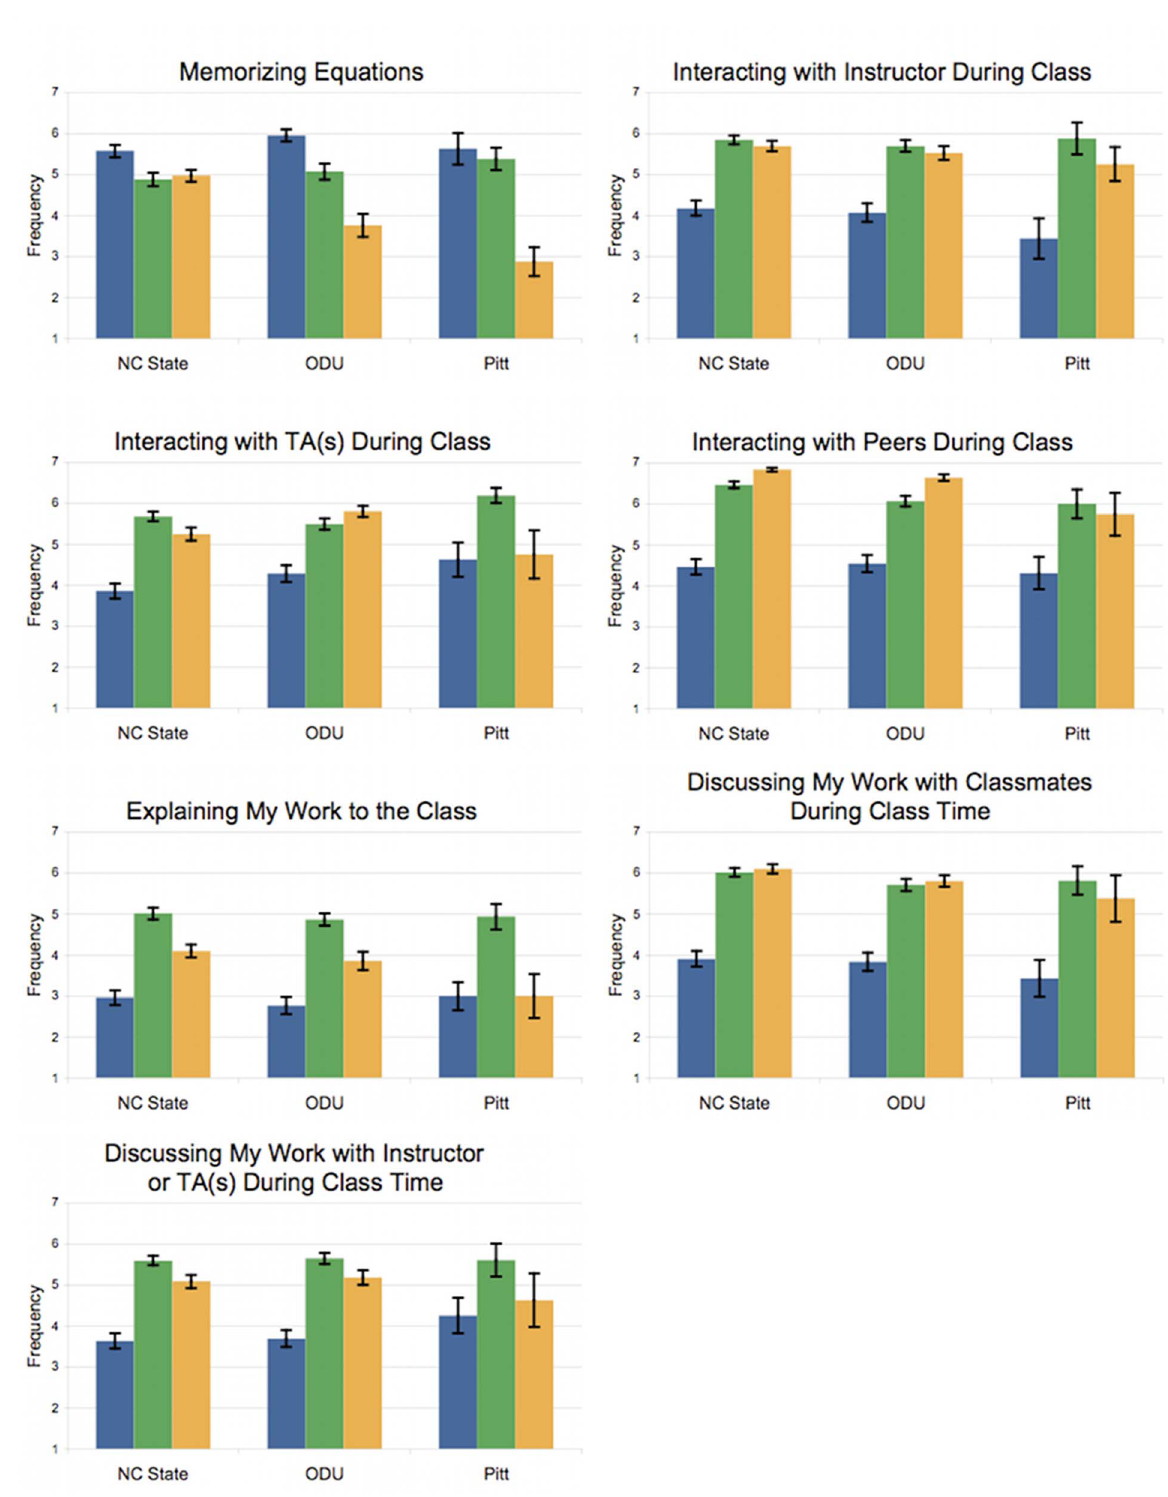
FIG. 2. (cid:1) Color (cid:2) The extent to which students at each school initially expected (cid:1) blue, first column (cid:2) , expected after orientation (cid:1) green, second column (cid:2) , and experienced (cid:1) orange, third column (cid:2) items 9–15 on the